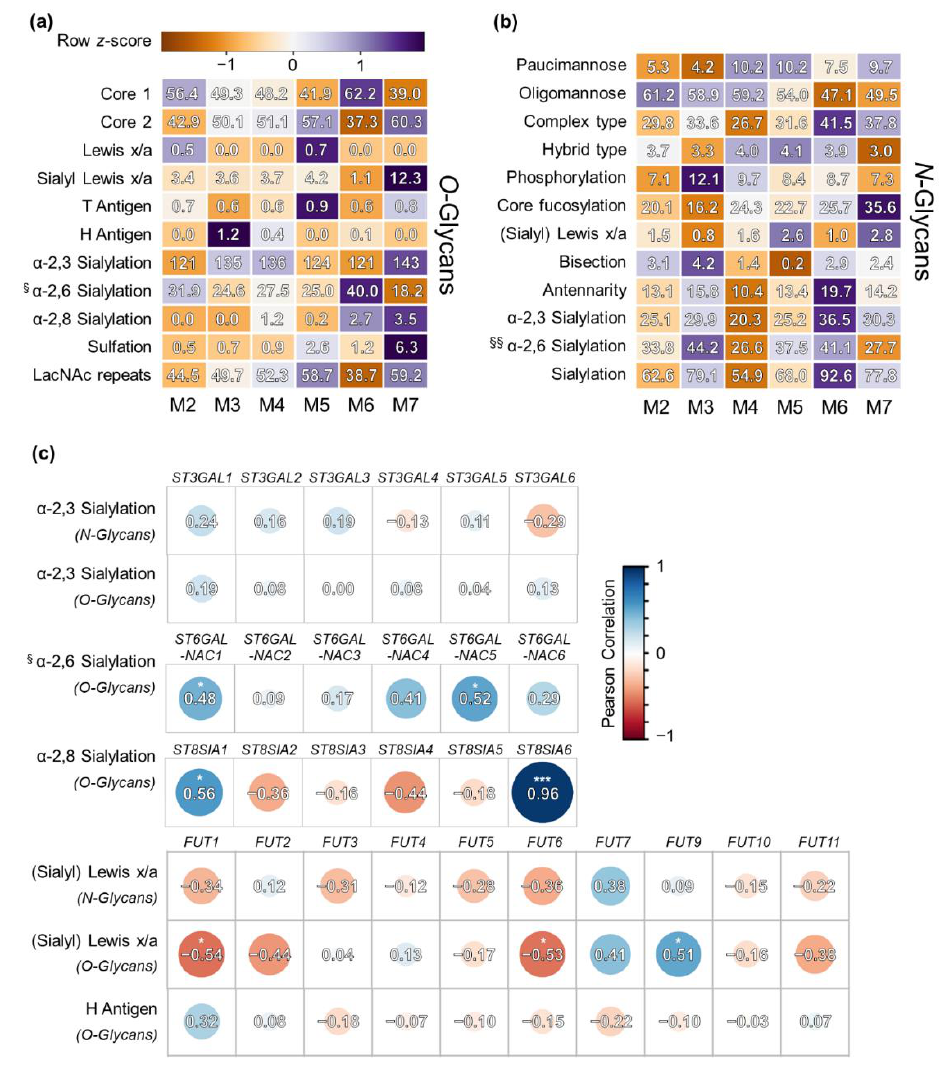
Figure 4. Overview of glycan types/derived traits and correlation analysis with GST expression data. In panel ( a ), O -glycan associated features are represented, whereas in panel ( b ), N -glycan derived features are depicted. The color scale represents the z-score after independent z-transformation of each glycan feature. The associated numeric values within the boxes show the average fractional abundance of derived traits and glycan types in a FAB group. § indicates α -2,6 sialylation on the core GalNAc of O -glycans and §§ α -2,6 sialylation on terminal galactose residues of N -glycans. ( c ) Pearson correlation of selected glycan-antigens with transcriptomics data of relevant GSTs. Correlation coefficients are indicated by the size and color of the circles, as well as the associated numeric values. Significant values are marked (* for p ≤ 0.05, and *** for p ≤ 0.001).